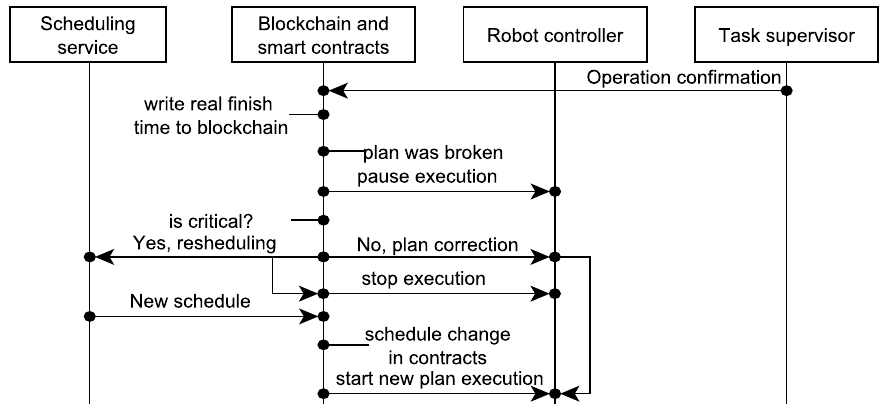
Figure 6. Process for